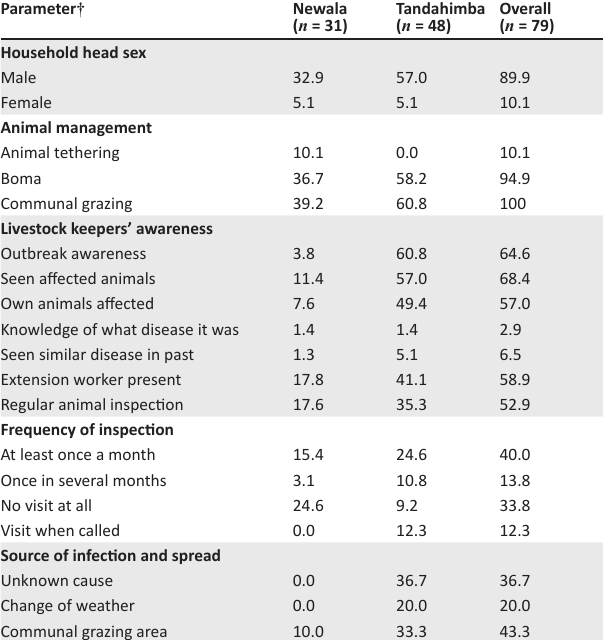
TABLE 2: Proportions of respondents’ sex, animal management, awareness of the disease, source and spreading of the infection and veterinary extension services. Parameter † Newala ( n = 31)